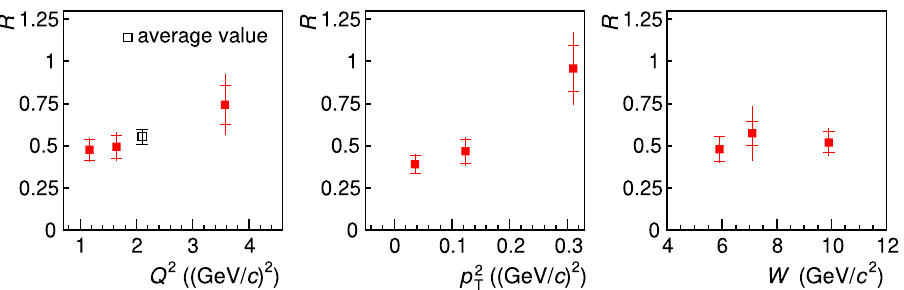
Fig. 10 Q 2 , p 2 and W dependences of the NPE-to-UPE asymmetry of the transverse cross section for the transition γ ∗ T represents the value over the total kinematic region. Inner error bars represent statistical uncertainties and outer ones statistical and systematic uncertainties added in quadrature